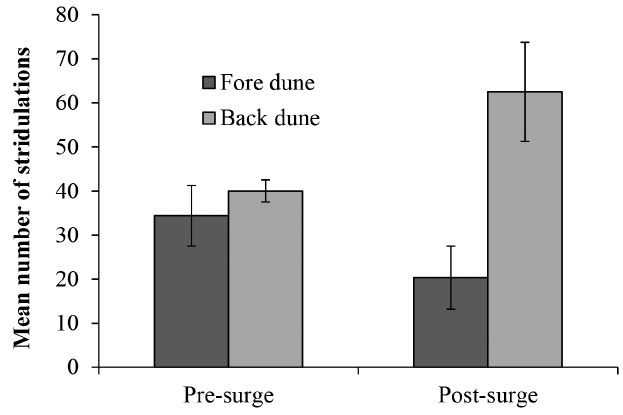
Fig. 4. The mean number of stridulating males recorded on the fore and back dunes pre- and post-surge.